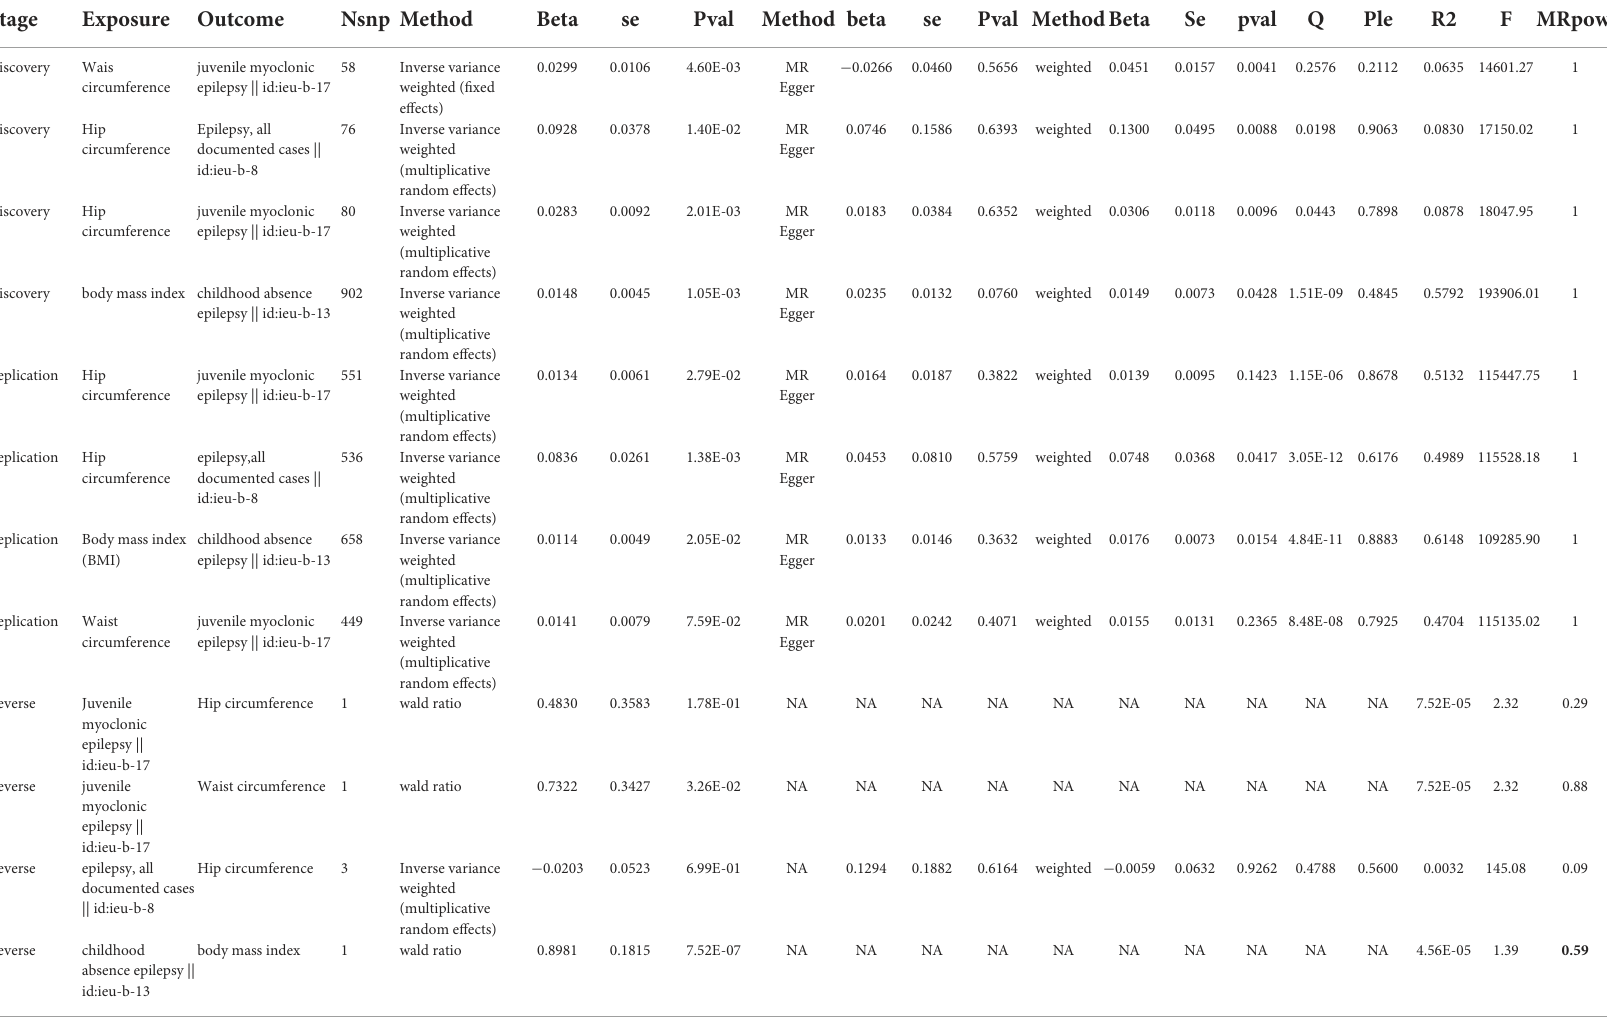
TABLE 1 Stage indicates the stage of our MR study, which can be divided into the discovery set, the validation set, and reverse MR; exp indicates the exposure in the MR study; out indicates the outcome in MR study; nsnp indicates the number of instrumental variables used; method indicates the meta method used, which can be divided into IVW, MR Egger, and Weighted median; beta refers to the effect size in the MR analysis; se exhibits the standard error in MR analysis; p indicates the statistical significance in the MR analysis; Q indicates the significance of the heterogeneity test in the MR analysis; Ple indicates the significance level of the multiplicity test in the MR analysis; r 2 indicates the degree of explanation of the instrumental variable for the exposure, with larger values indicating a greater degree of explanation for the exposure; f indicates the F-test statistic, with larger values indicating that the instrumental variable used in the MR analysis is a strong instrumental variable.